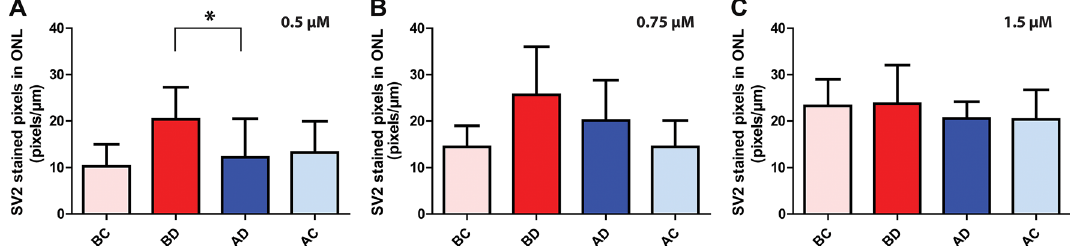
Figure 3. Effect of AR13503 intravitreal injection on axonal retraction of photoreceptors 2 h after retinal detachment. (A) 0.5 μM AR13503 treatment. There was a 40.2% decrease between the treated (AD) and the untreated (BD) detached areas (n = 3 animals, *p < 0.0001, using 120–180 images/animal, + /− SD). ( B) 0.75 μM AR13503 treatment. Retraction was reduced by 21.6% in the treated detached area (AD) compared to the untreated detached area (BD) (n = 3 animals, p = 0.48, using 120–180 images/animal, + /− SD). ( C) 1.5 μM AR13503 treatment. There was a 13.5% decrease in axonal retraction in the treated detached area (n = 4 animals, p = 0.43 using 120–180 images/animal, + /− SD). Only the 0.5 μM AR13503 dose showed a significant reduction in retraction. BC, AC, attached areas of the untreated and treated